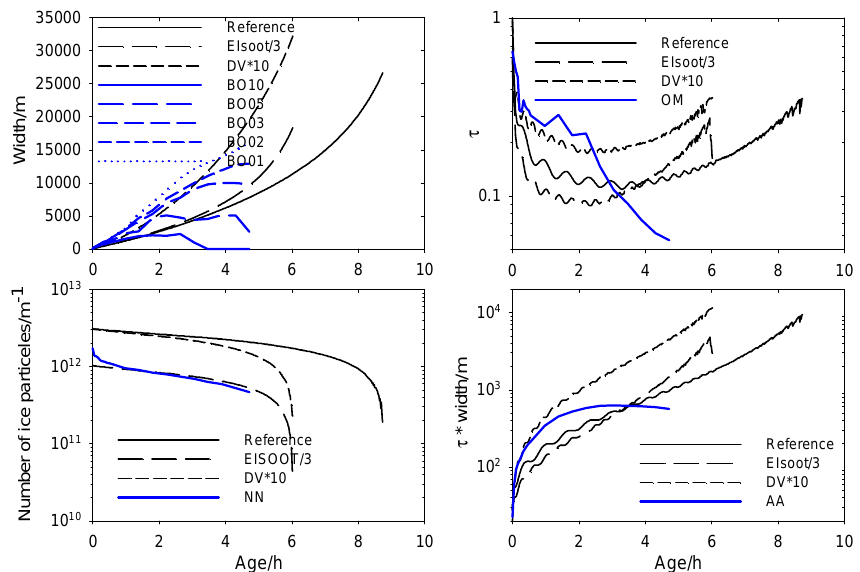
Fig. 14. Comparison of contrail properties versus plume age as computed with CoCiP (black lines) and with a 2d model (blue lines). CoCiP is run for three sets of parameters: reference, reduced soot emissions, and increased vertical diffusivity. Top-left panel: Black: CoCiP width, blue curves: 2d model width results BOnn, for various threshold values nn/100 of optical depth. Top-right: black: CoCiP optical depth τ , blue: 2d model τ OM. Bottom-left: black: CoCiP number concentration, blue: 2d model number concentration NN. Bottom-right: black: CoCiP product τB of optical depth and width, blue: 2d integrated optical depth